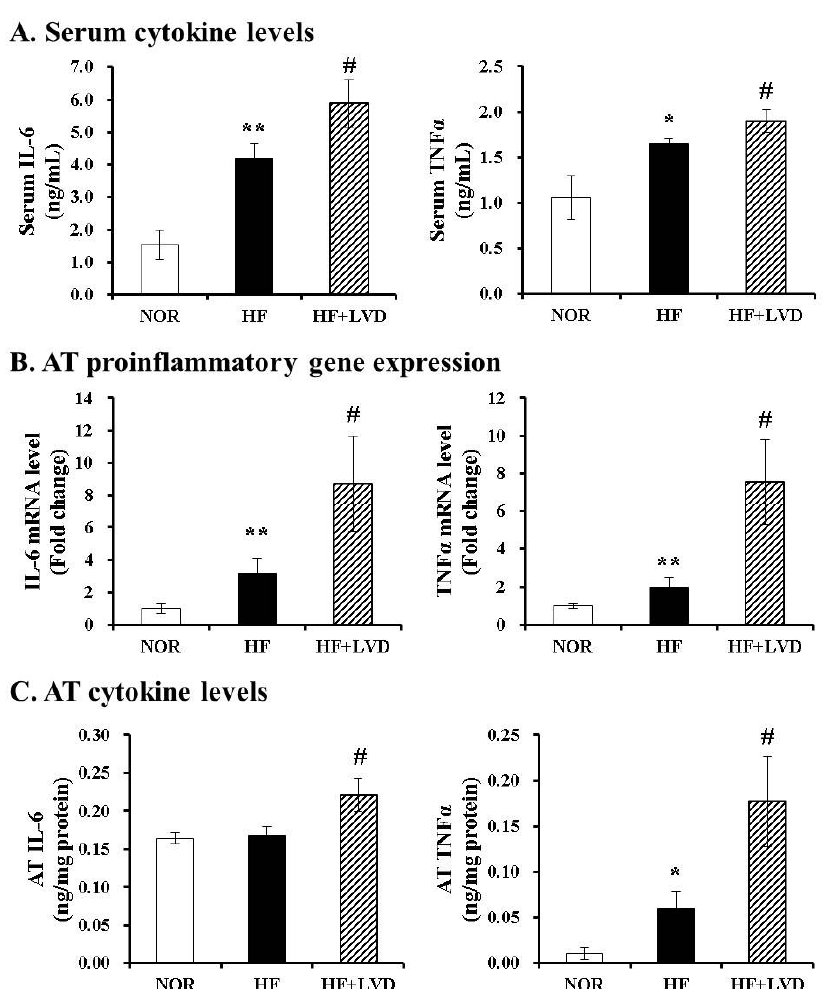
Figure 3. Vitamin D insufficiency increases local and systemic proinflammatory cytokine level. Serum levels of IL ‐ 6 and TNF α were expressed as ng/mL ( A ); Gene expression was measured, normalized for all samples to β‐ actin and expressed as the fold change compared to NOR ( B ); Measurements of IL ‐ 6 and TNF α in adipose tissue ( C ) were normalized to their respective protein concentrations and expressed as ng/mg protein. Values are expressed as the mean ± SEM. * p < 0.05; ** p < 0.01 compared to NOR. # p < 0.05 compared to HF. NOR, 10% fat diet with 1000 IU vitamin D ( n = 9); HF, 45% fat diet with 1000 IU vitamin D ( n = 7); HF+LVD, 45% fat diet containing 25 IU vitamin D ( n = 7).